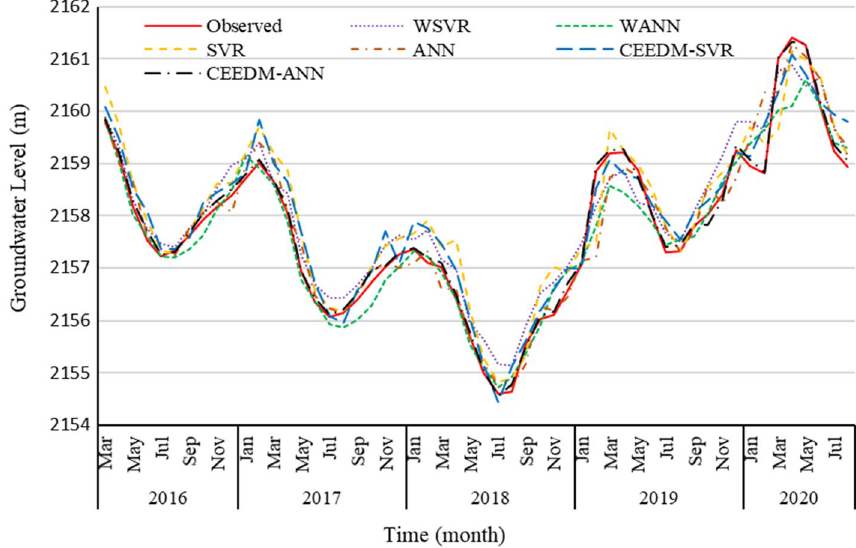
Fig. 13 Comparison of the models used-step of